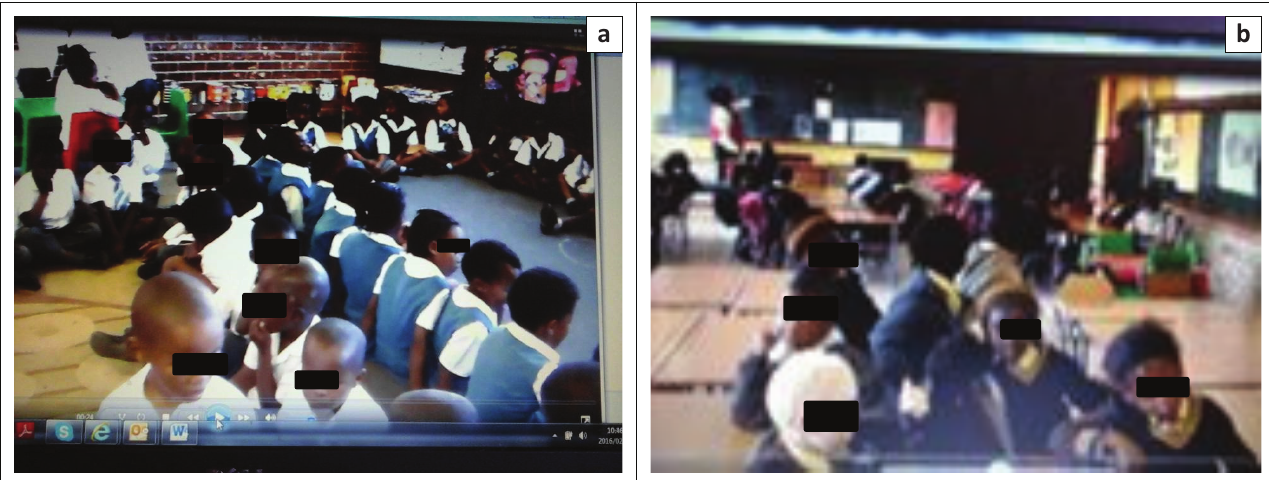
FIGURE 1: Composite